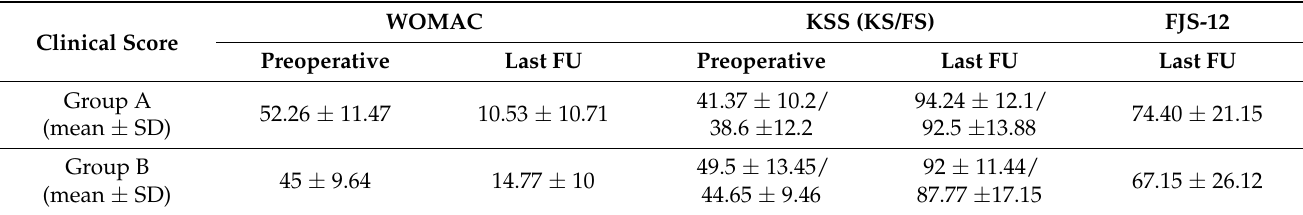
Table 3. Clinical results for the two study